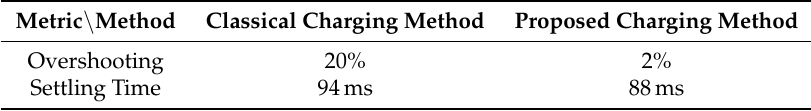
Table 2. Summaries of experiment results in Figure